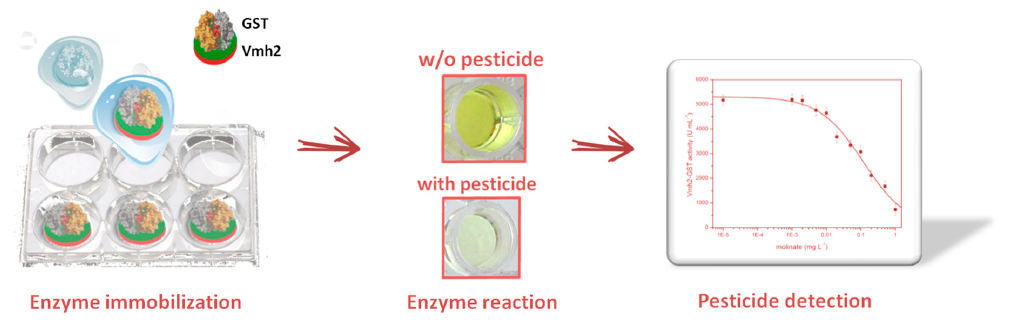
Figure 3. Pesticide biosensor developed on polystyrene multiwell plate coated with Vmh2 ‐ GST fused proteins